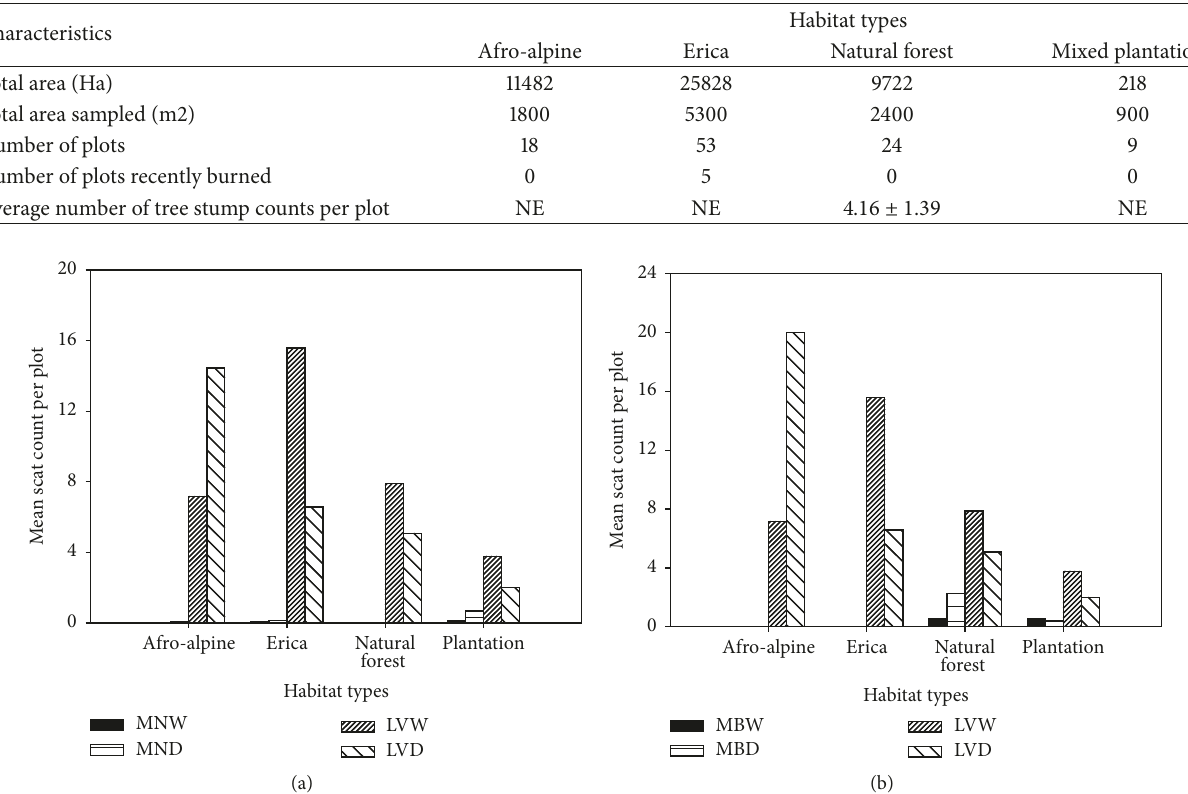
Figure 2: Mean scat count of mountain nyala (a), Menelik’s bushbuck (b), and livestock per plot among dominant habitat